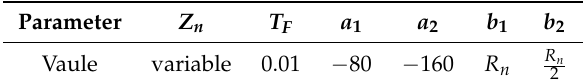
Figure 7. Operating sequence of the trigger-type superconducting fault current limiter (T-SFCL). Table 4. Parameters of the T-SFCL.